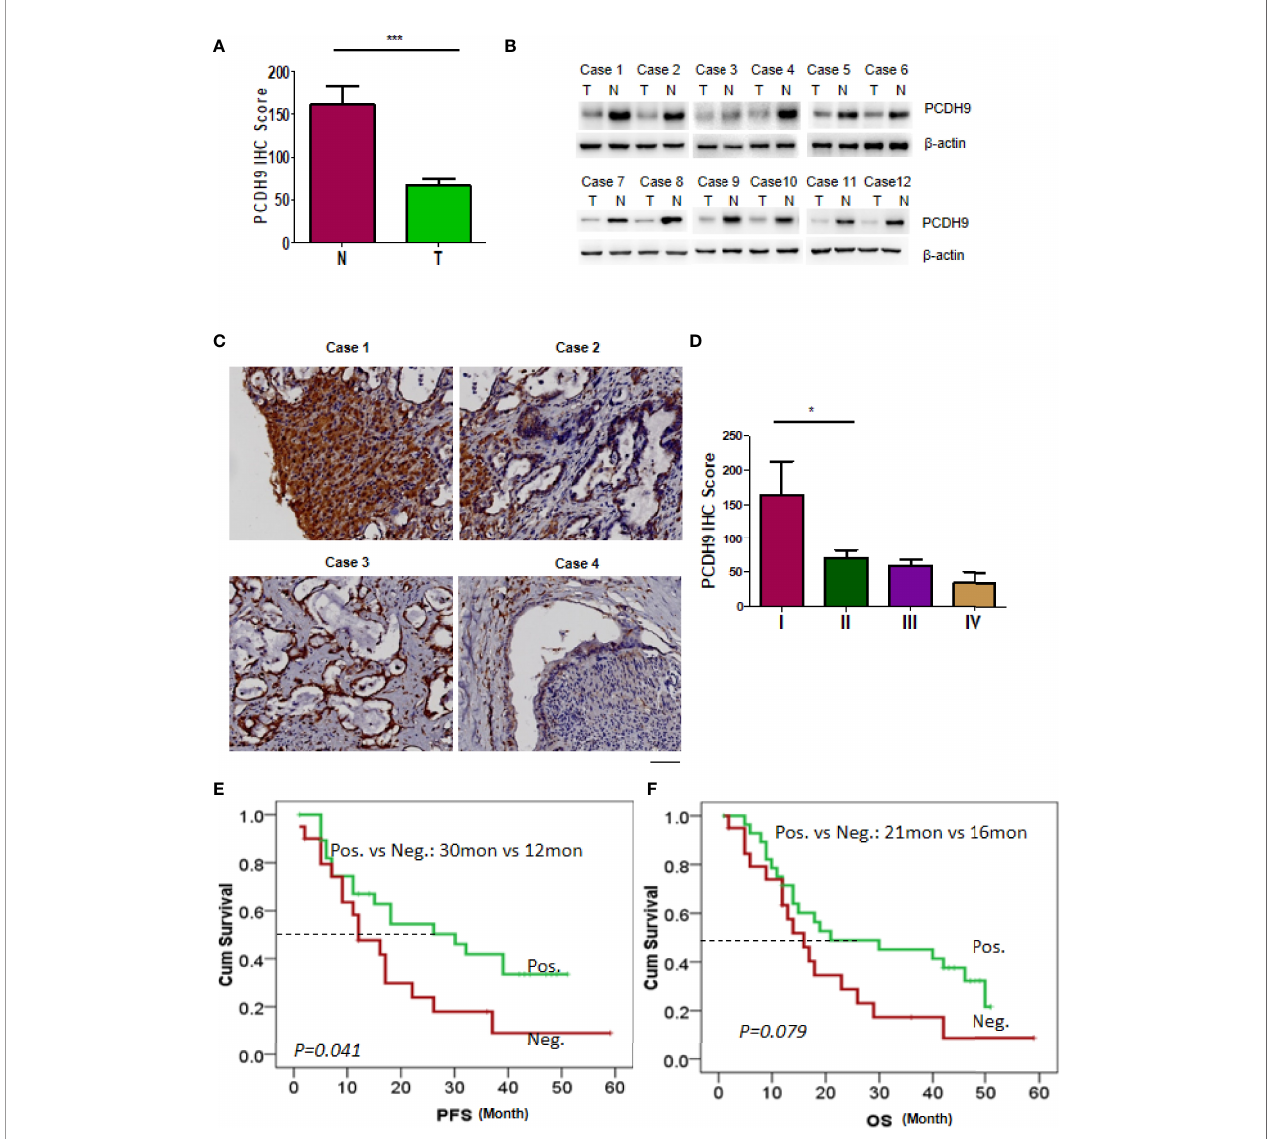
FIGURE 5 | Expression of PCDH9 in patients with cholangiocarcinoma (CCA) showed clinical signi fi cance. (A) Immunohistochemistry (IHC) was used to detect the expression of PCDH9 protein in the normal liver tissue and CCA tissue. The IHC intensity was scored, and the statistical data is shown ***p < 0.001. (B) Twelve paired CCA and normal tissue were analyzed by Western blotting using antibodies against PCDH9. (C) Representative patterns of PCDH9 protein in CCA samples were displayed by IHC. Scale bar, 400 m m. (D) CCA samples were analyzed by IHC and scored for four grades. The statistical data are shown *p < 0.05. (E) Patients with PCDH9 expression had a longer time to recur than those without PCDH9 expression (median PFS: 32 vs 12 months, p = 0.041). (F) Patients with PCDH9 expression had a longer overall survival (OS) as compared with those without PCDH9 expression (median OS: 21 vs 16 months, p =